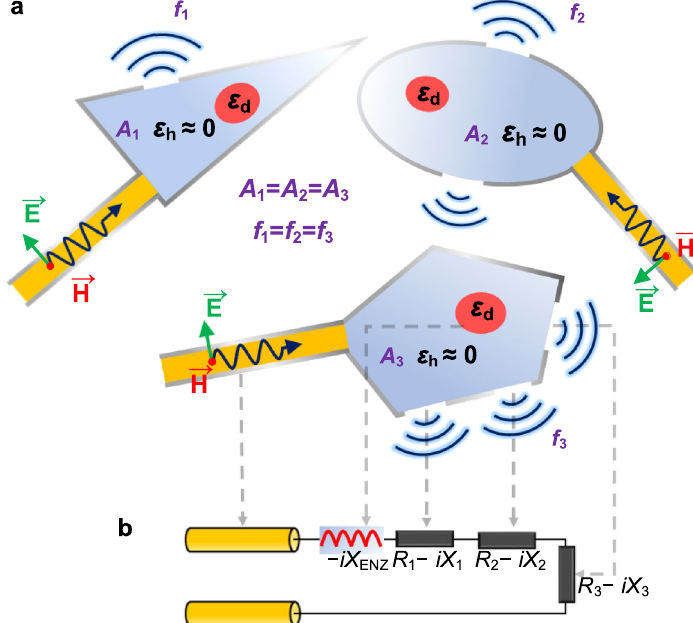
Fig. 1 General idea of geometry-independent antenna. a Sketch of ENZ antennas with arbitrary cross-sectional shapes supporting geometry-independent modes. With their different geometries, the radiation directions of the antennas change from case to case, while the frequency is kept the same. b Equivalent lumped-circuit model of the proposed structure, which is based on an ENZ cavity fed by a